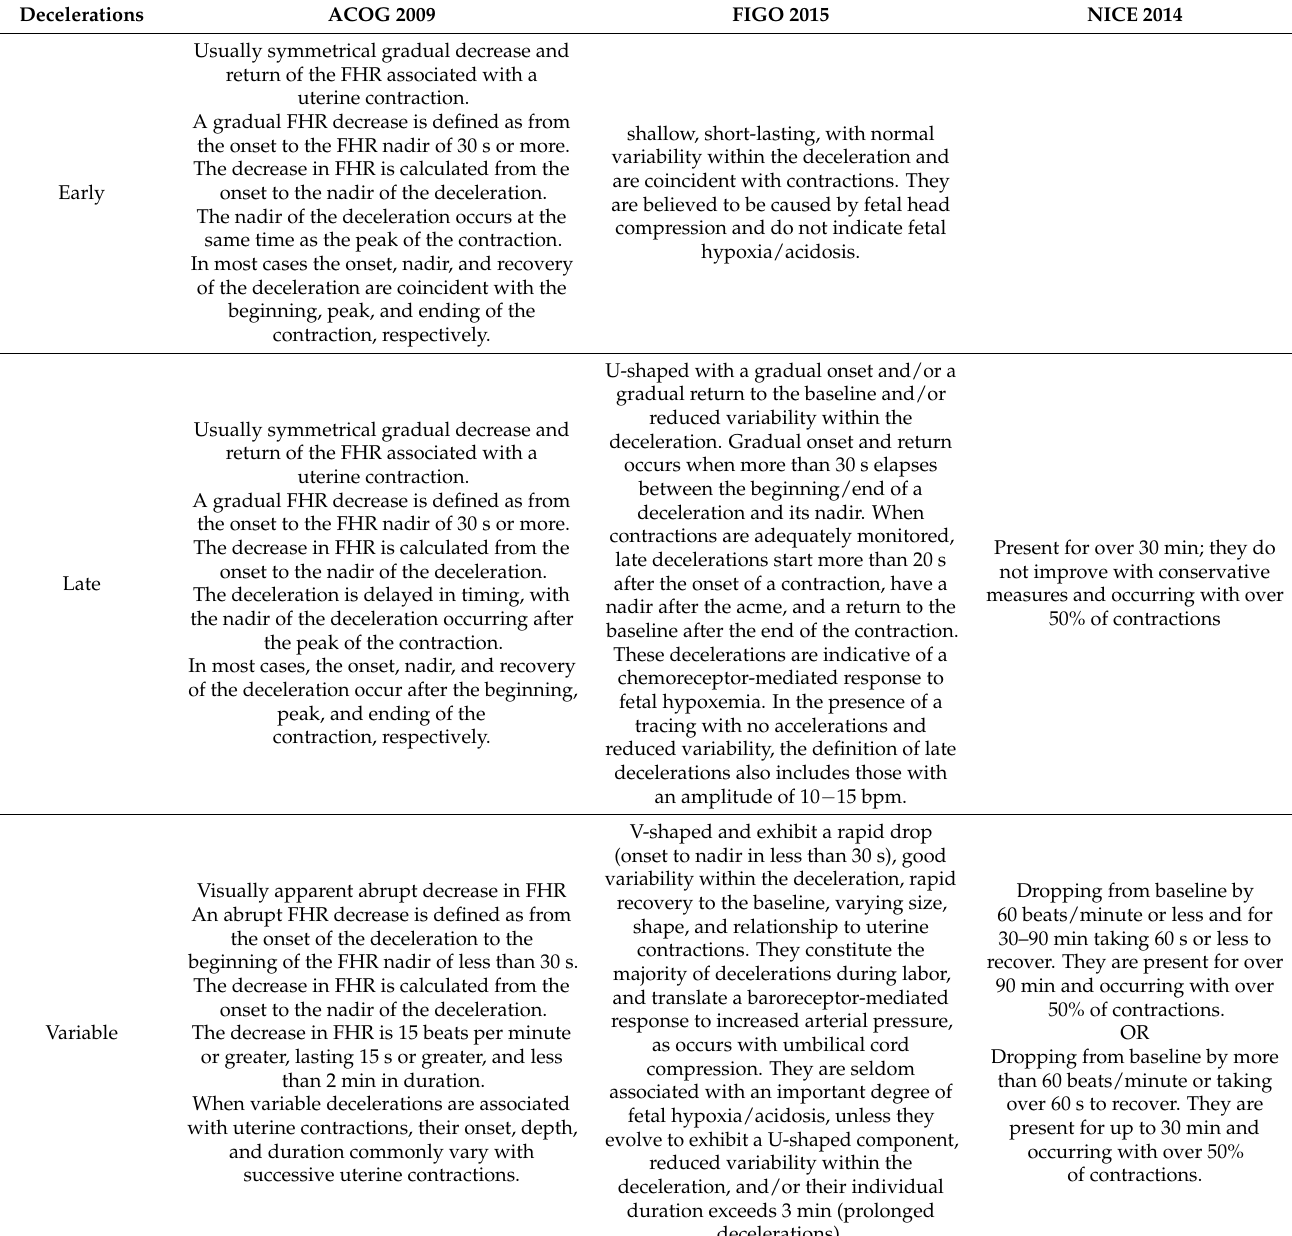
Table 1. Deceleration definitions according to the recommendations of the major scientific societies in the obstetric